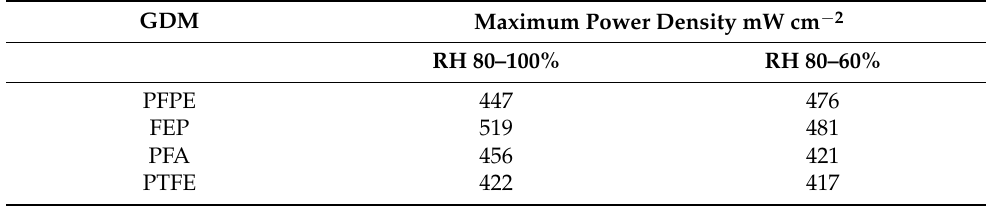
Table 4. Maximum power density values achieved (at 60 ◦ C and RH 80–100% and 80–60%) by fuel cells assembled with GDMs treated with PFPE, FEP, PFA, and PTFE. Data from